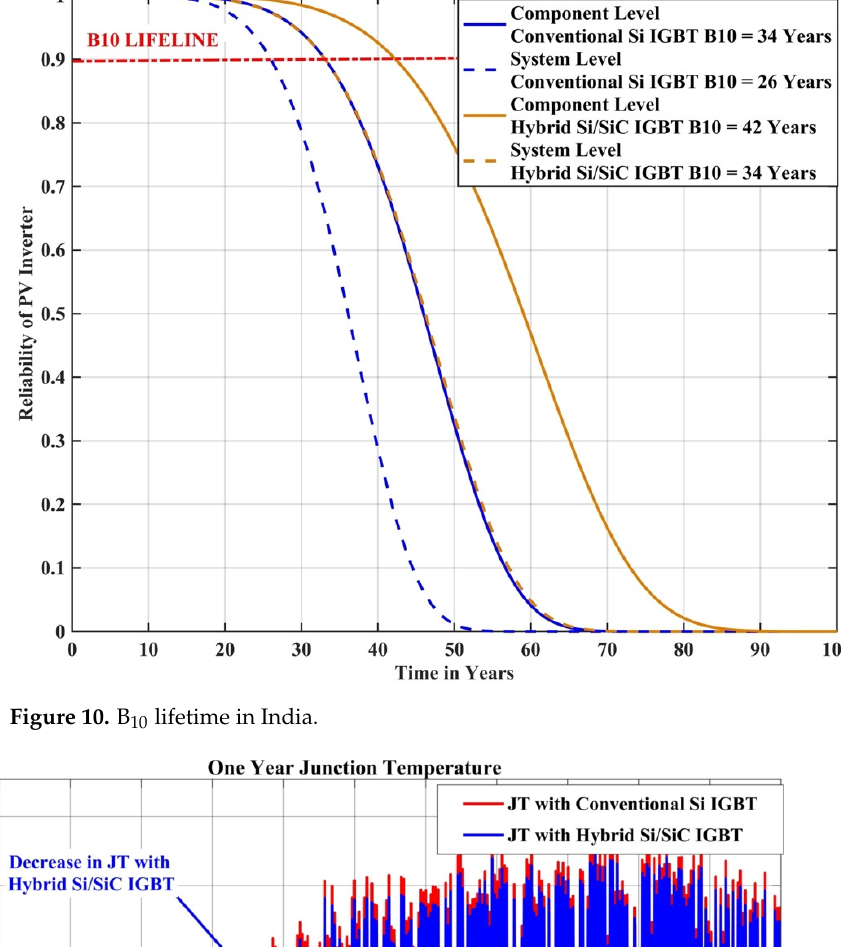
Figure 10. B 10 lifetime in India.